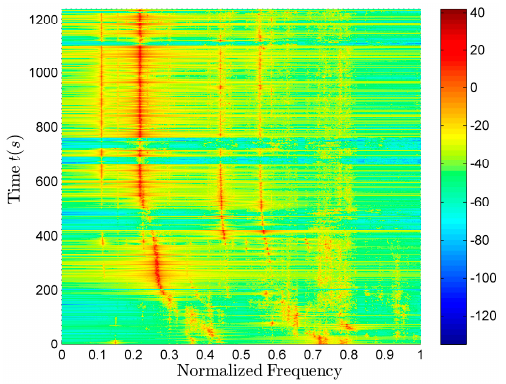
Figure 13. The adaptive line spectrum enhancement results of the v z